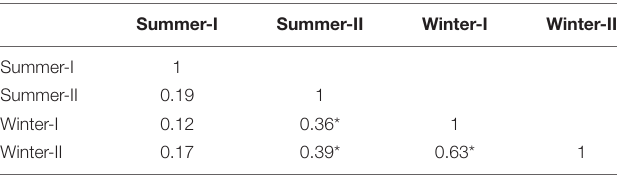
TABLE 2 | Correlation coefficients between the time series of summer and winter precipitation in regions I and region II. Summer-I Summer-II Winter-I